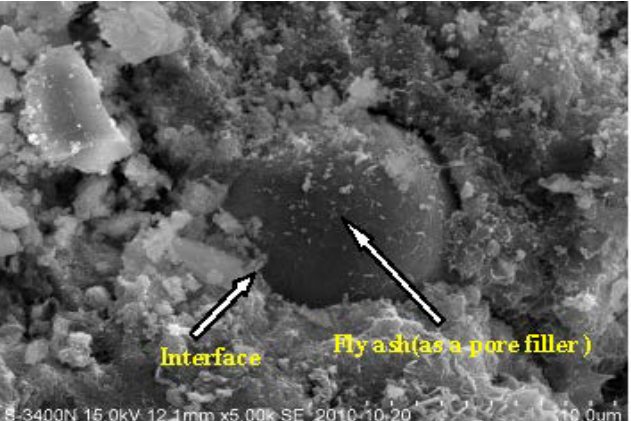
Figure 4. Scanning electron image of specimen C15 hydrated for 28 days showing morphology of fly ash